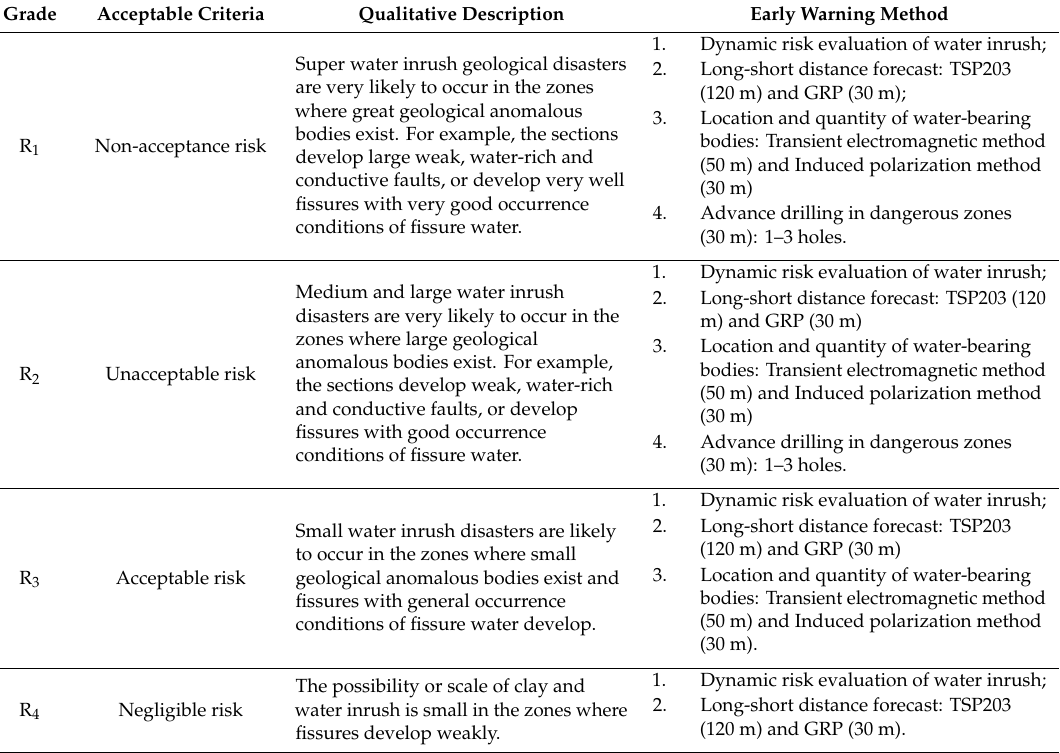
Table 6. Risk acceptance criteria and early warning for water